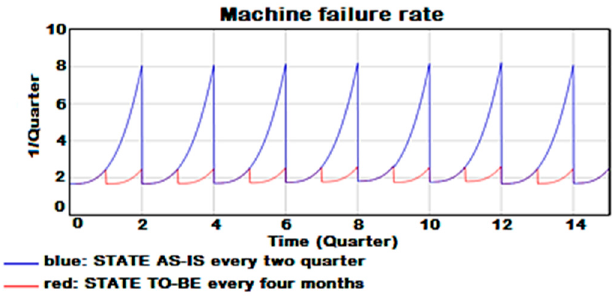
Figure 13. AS-IS/TO-BE machine failure comparison.